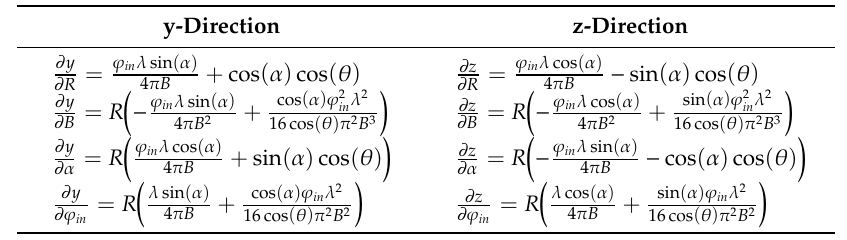
Table 1. Error transfer coe ffi